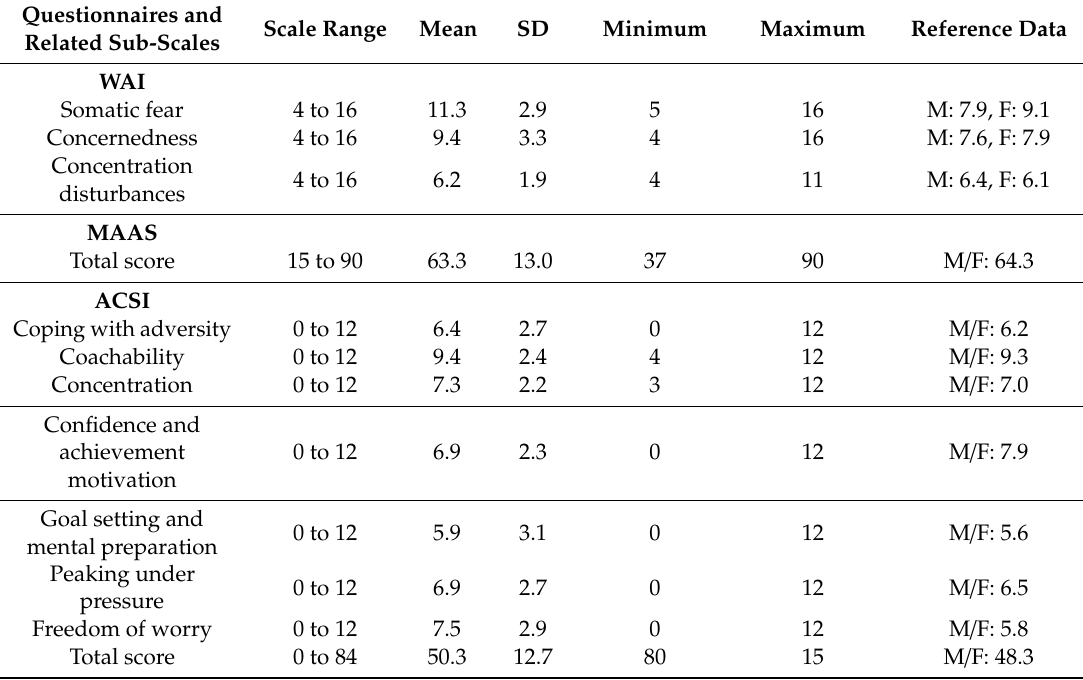
Table 2. Descriptive statistics of the survey